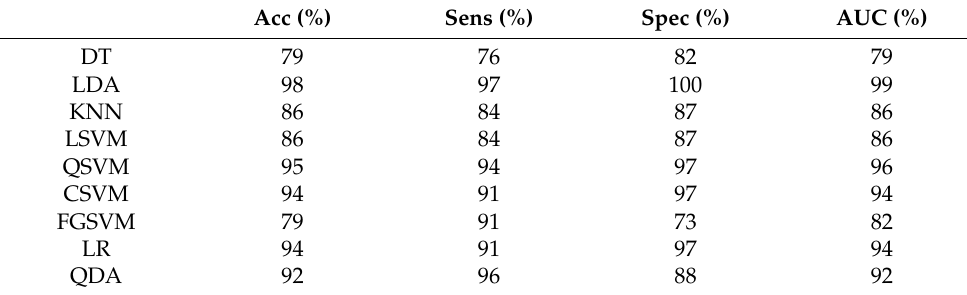
Table 4. Results for the LSDL for Dataset 1.